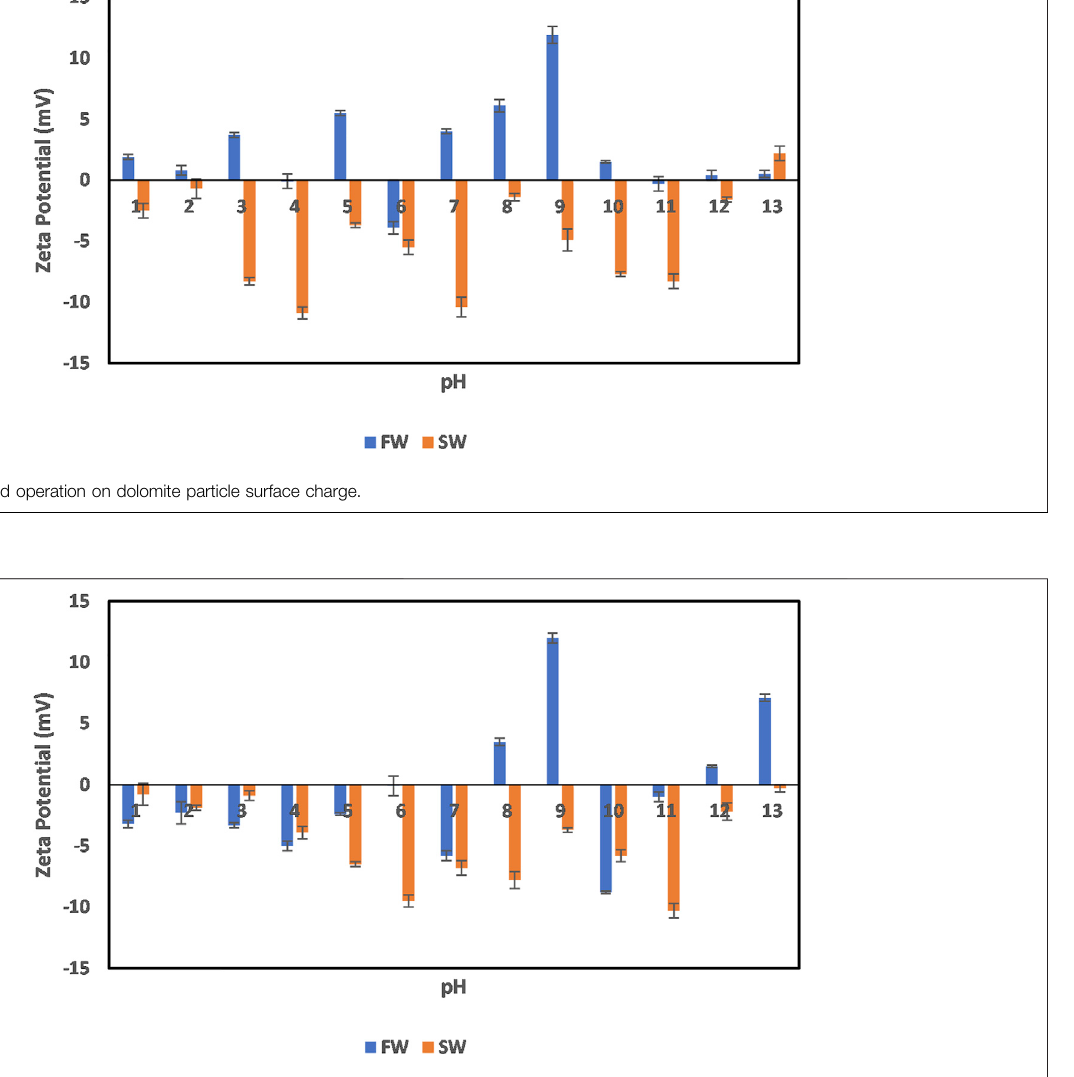
FIGURE 7 | Effect of oil fi eld operation on feldspar particle surface